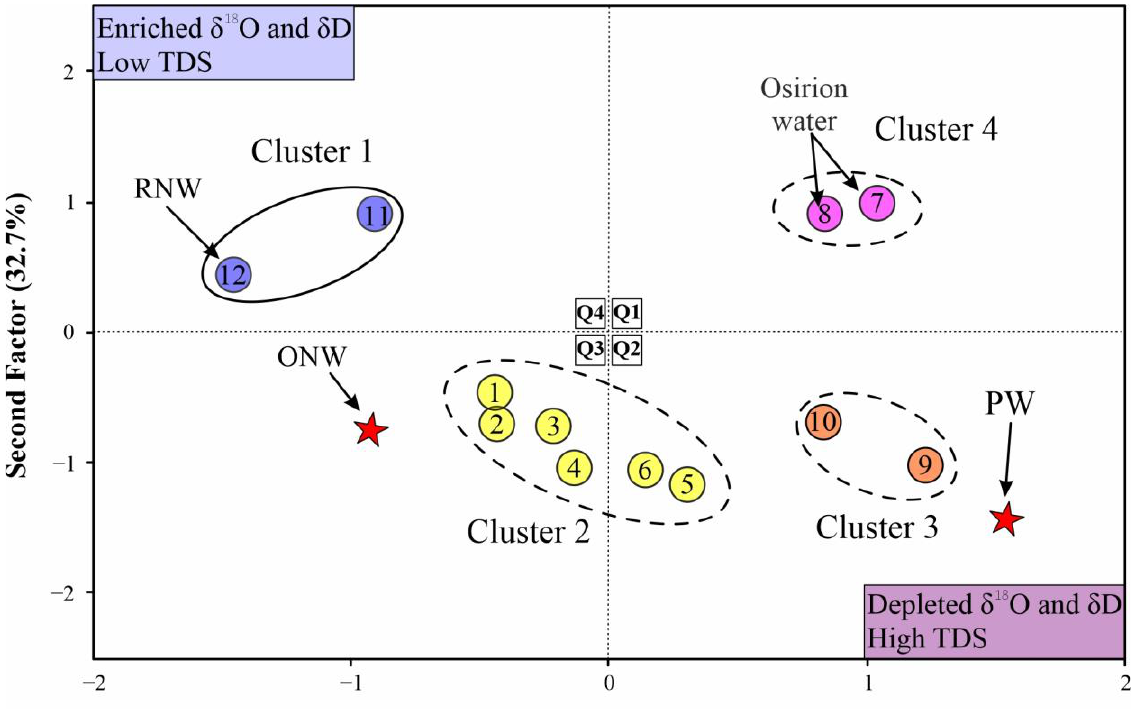
Figure 12. Four clusters on the Q-mode factor analysis plan.